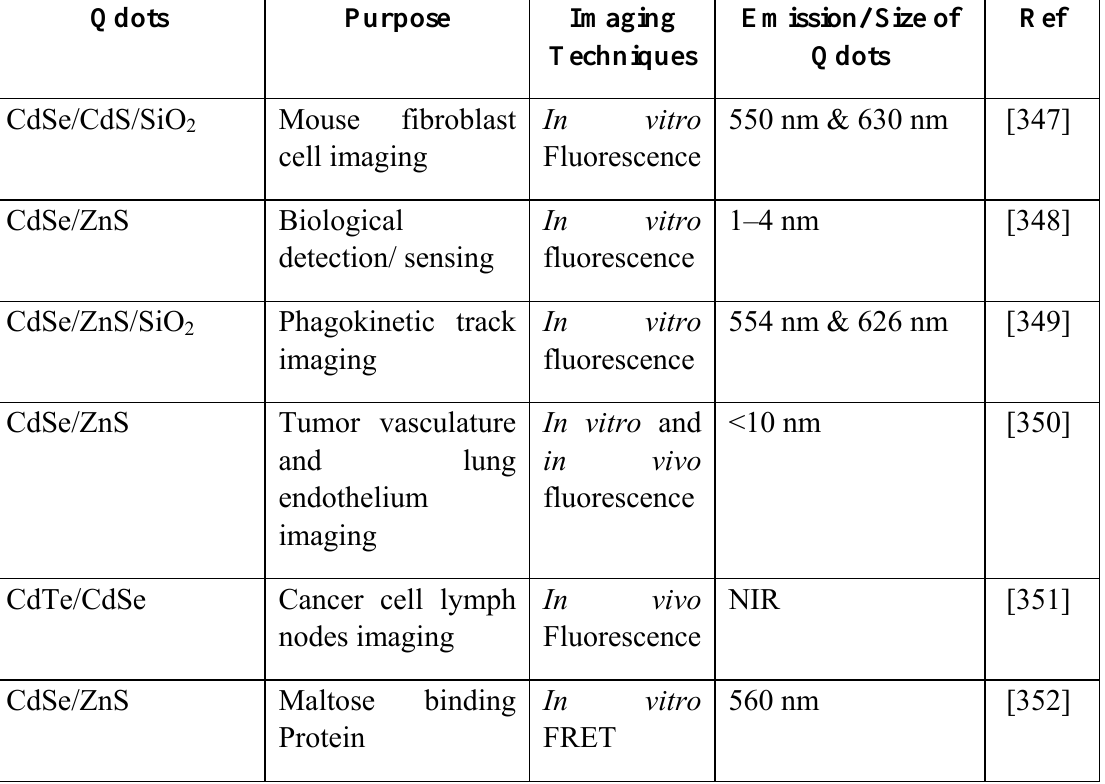
Table 11. Selected in vitro and in vivo bioimaging studies using